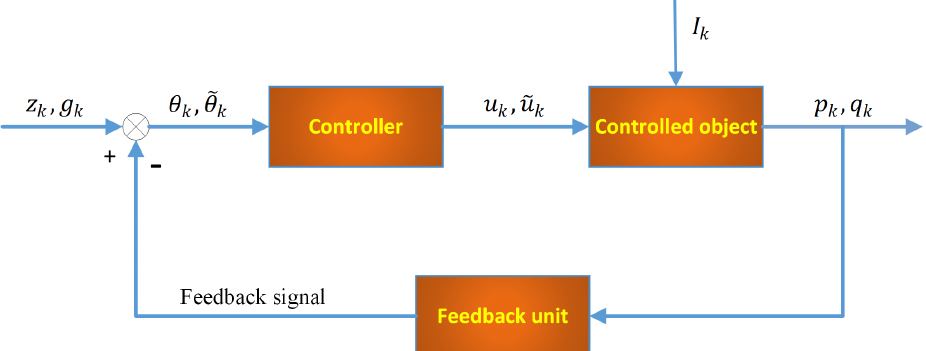
Figure 1. Framework of feedback